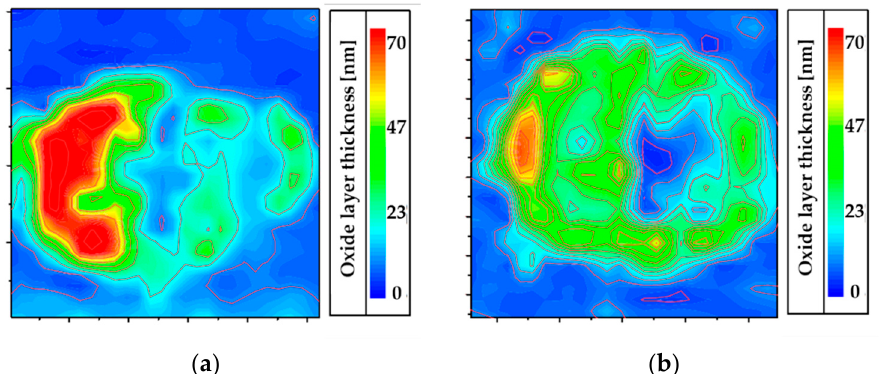
Figure 6. WDS analysis of the resulting oxide layer (acceleration voltage 8 keV): ( a ) Example 1 for a contact area stressed by a vibration and temperature cycle test; ( b ) Example 2 for a contact area stressed by a vibration and temperature cycle test.